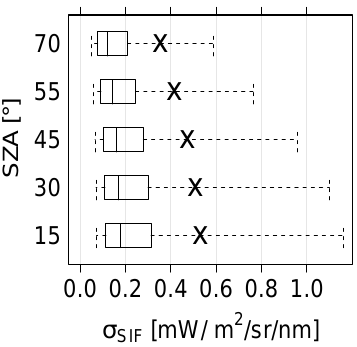
Figure 7. Estimated SIF error in dependence on the simulated so- lar zenith angle (SZA) for the same retrieval properties as in Fig. 5 (eight provided PCs, 720–758nm retrieval window). The vertical bar represents the median, the box/error bar covers 50/90% of the theoretical random errors as calculated from Eq. (8). The crosses de- note the estimated root-mean-square errors of the simulation-based retrieval